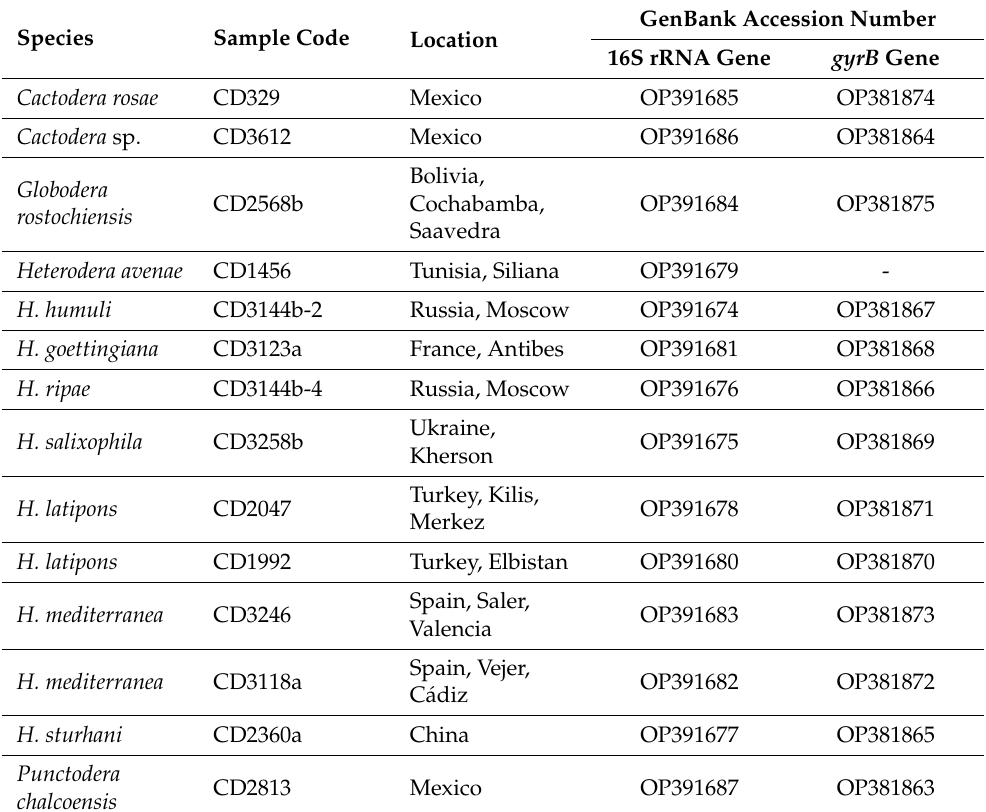
Table 1. List of cyst-nematode species with Cardinium found during this study. Species Sample Code